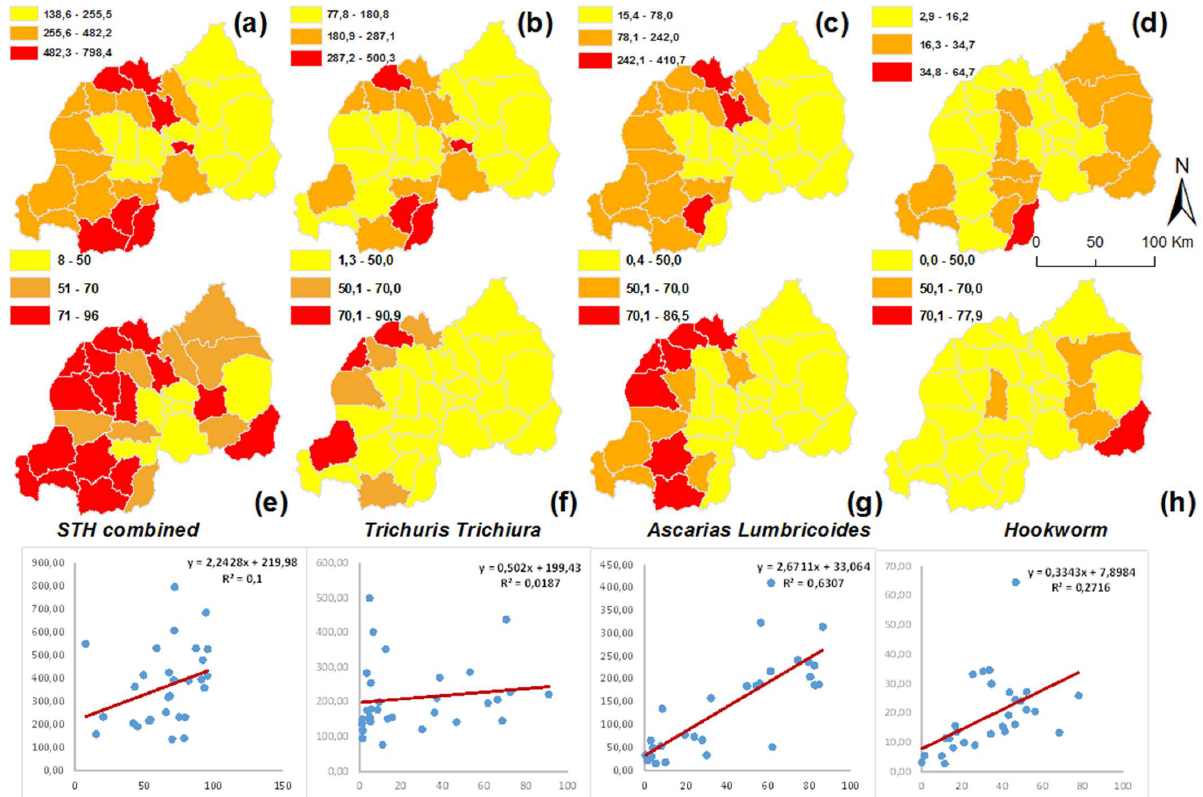
Figure 3. STH incidence and prevalence rates and their correlation at the district level. Starting from the left-upper corner, incidence maps for combined STHs ( a ), for T. trichiura ( b ), for A. lumbricoides , ( c ) and for hookworm ( d ). The prevalence maps and scatter plots are shown for combined STH cases ( e ), individual cases with T. trichiura ( f ), A. lumbricoides ( g ) and hookworm ( h ).